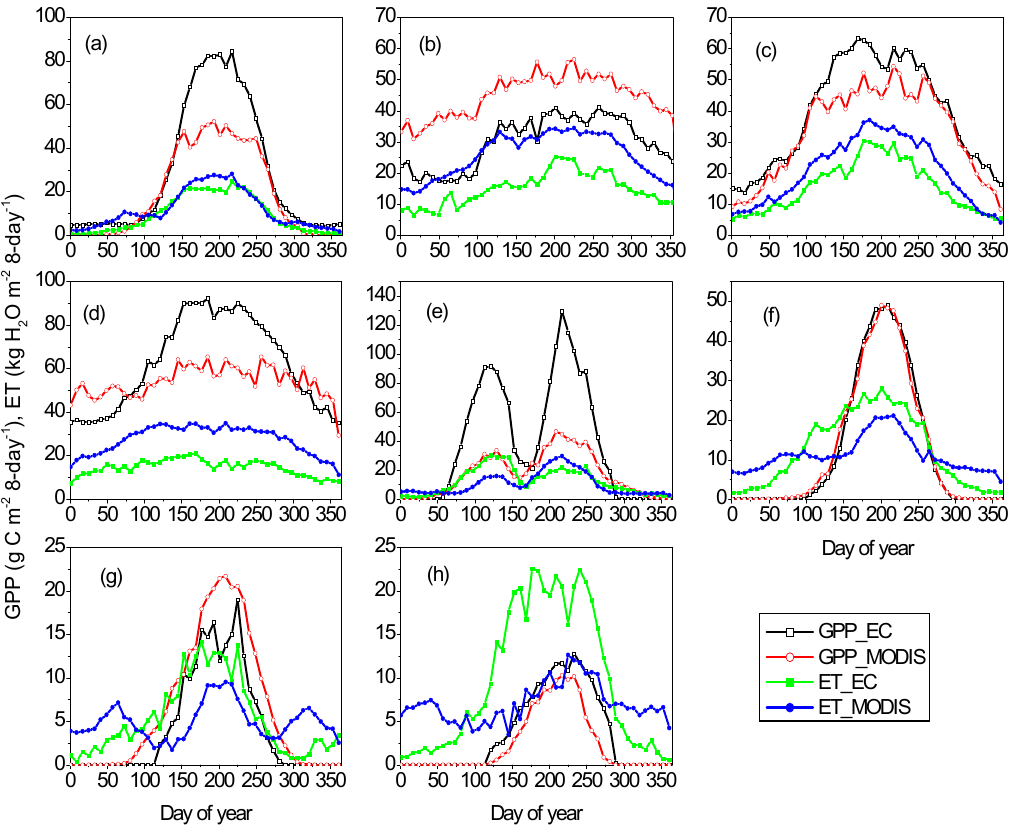
Figure 2. Comparison of MODIS- and eddy covariance-derived eight-day gross primary production (GPP) and evapotranspiration (ET) at eight ChinaFLUX sites. ( a ) CBS; ( b ) DHS; ( c ) QYZ; ( d ) XSBN; ( e ) YC; ( f ) HBGC; ( g ) NM; ( h )